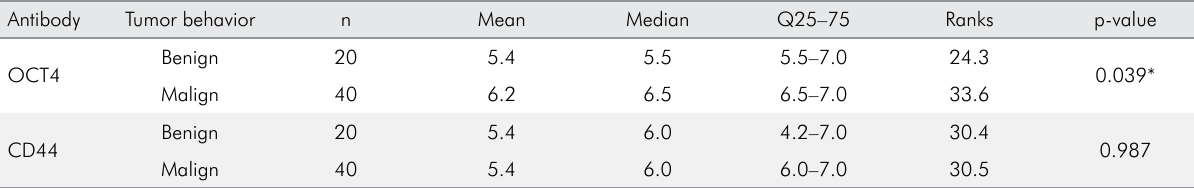
Table 2. Evaluation of OCT4 and CD44 immunoexpression according to lesion behavior, regardless of location. Antibody Tumor behavior n OCT4